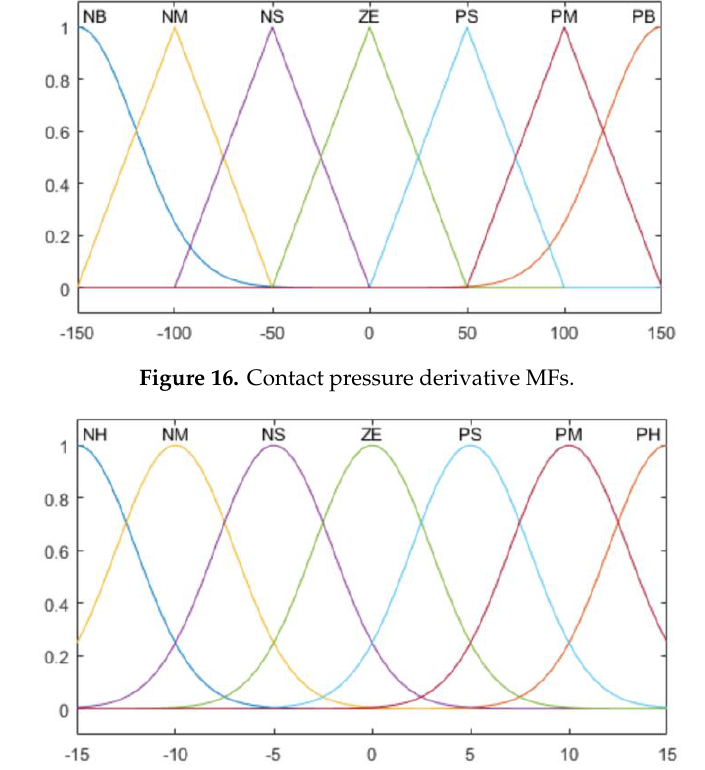
Figure 17. Optimal torque MFs.